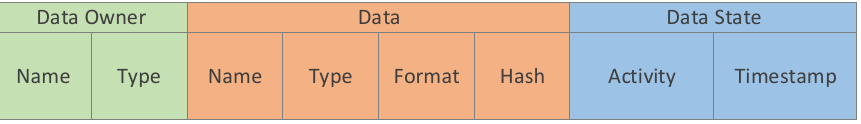
Figure 3. The traceability data